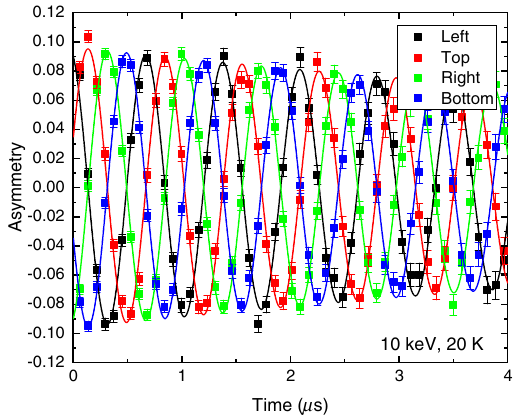
FIG. 10. (a) Strength of the monopolar field as a function of scaling α (blue) and scaling α by keeping α þ α ⊥ ¼ const FIG. 11. Typical LE- μ SR spectra (20 K, 10 keV, þ 10 mT) k k k (orange). In addition, we show the evolution of monopolar obtained for four positron detectors arranged around the strength by a uniaxial scaling of the dielectric constant for an sample. The solid lines are fits to the raw data with an exponen- isotropic (b) magnetoelectric response α ⊥ ¼ α and for a strongly tial envelope function, i.e., assuming a Lorentzian field k distribution. anisotropic (c) magnetoelectric response α ⊥ ¼ − 3 α k